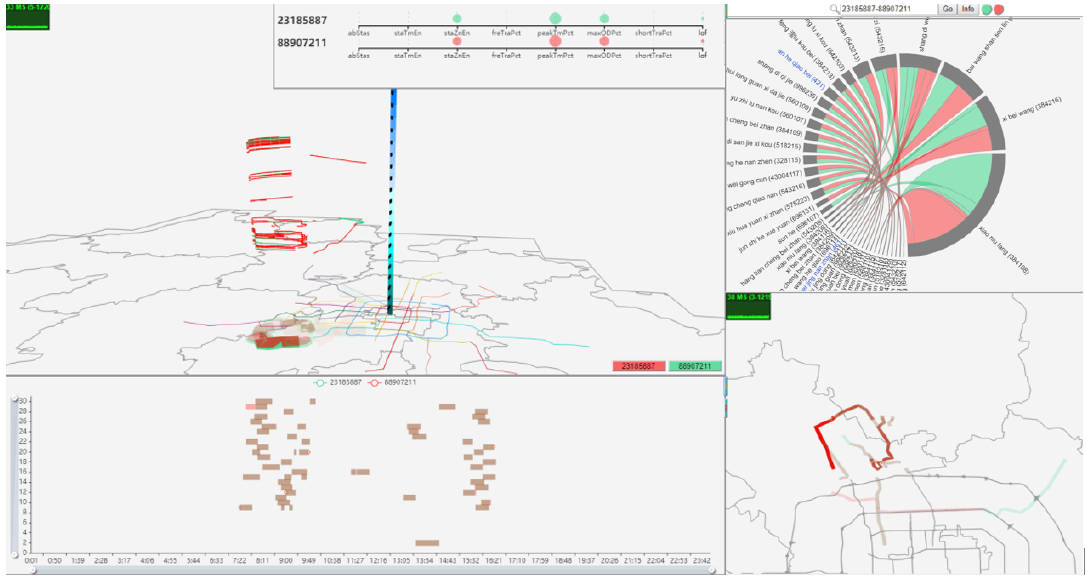
Figure 12. Normal passenger